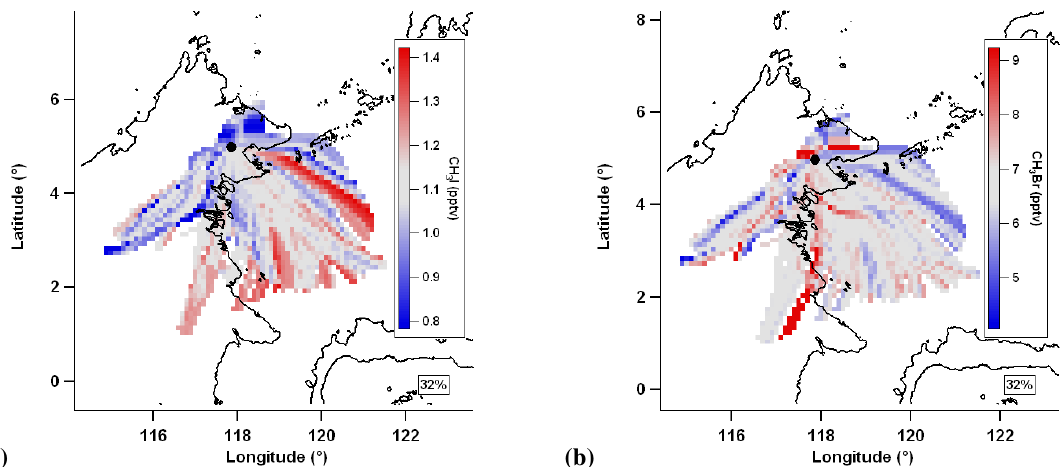
I and (b) methyl bromide CH Br. Grey is median 3 3